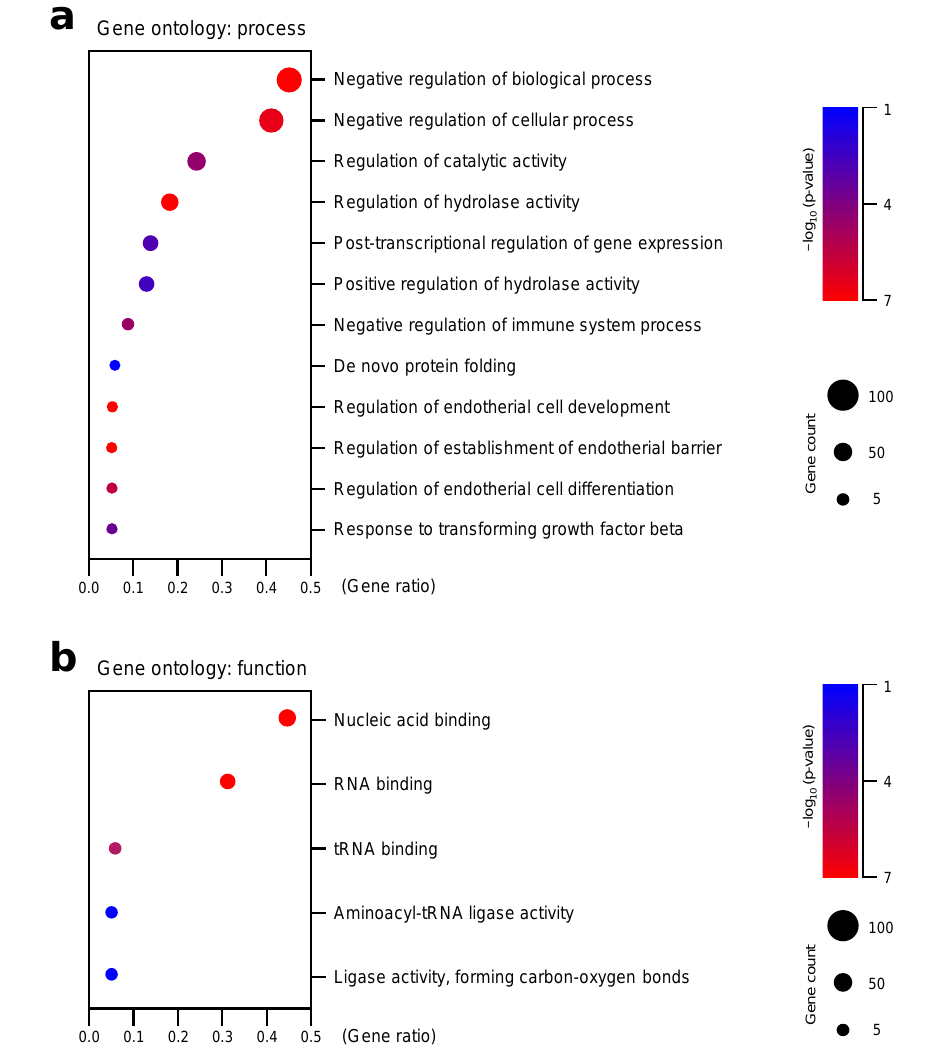
Figure 3. Analysis of gene ontology in cells treated with BPA. The classification of gene ontology (GO) functional enrichment analyses with the differentially expressed genes (DEGs) from comparisons of control and BPA-treated Y79 cells. The functional enriched classes of downregulated DEGs annotated by biological process ( a ) and molecular function ( b ).